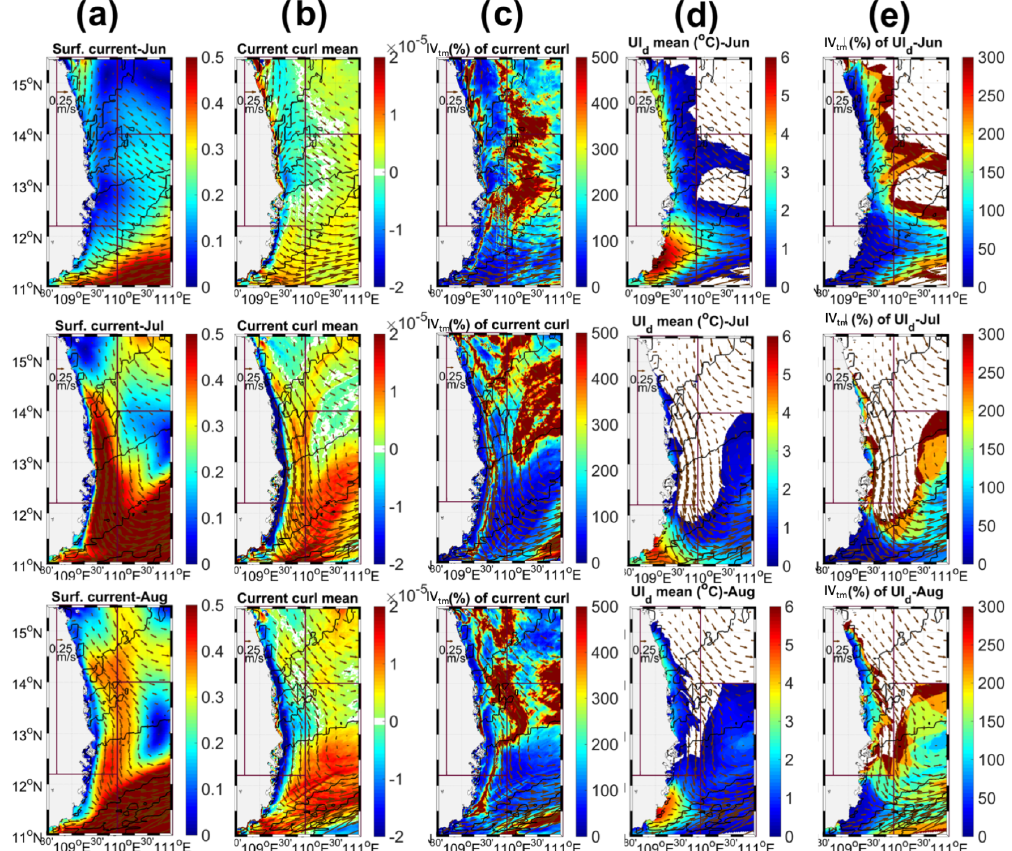
Figure 5. Maps of ensemble average of average surface current speed ( a , ms − 1 ) and vorticity ( b , s − 1 ) over each wind peak period over boxNC (highlighted in green in Fig. 2: first row 10 June–4 July, second row 17–22 July and third row 26–31 August), of UI d ( d , ◦ C) on the day of maximum UI d , boxNC over each period and of relative intrinsic variability IV tm of average surface current vorticity ( c , %) and UI d ( e , %) over each period. Black contours: 3.10 − 7 Nm − 3 iso-contours of average wind stress curl during each period. Arrows: average surface current (ms − 1